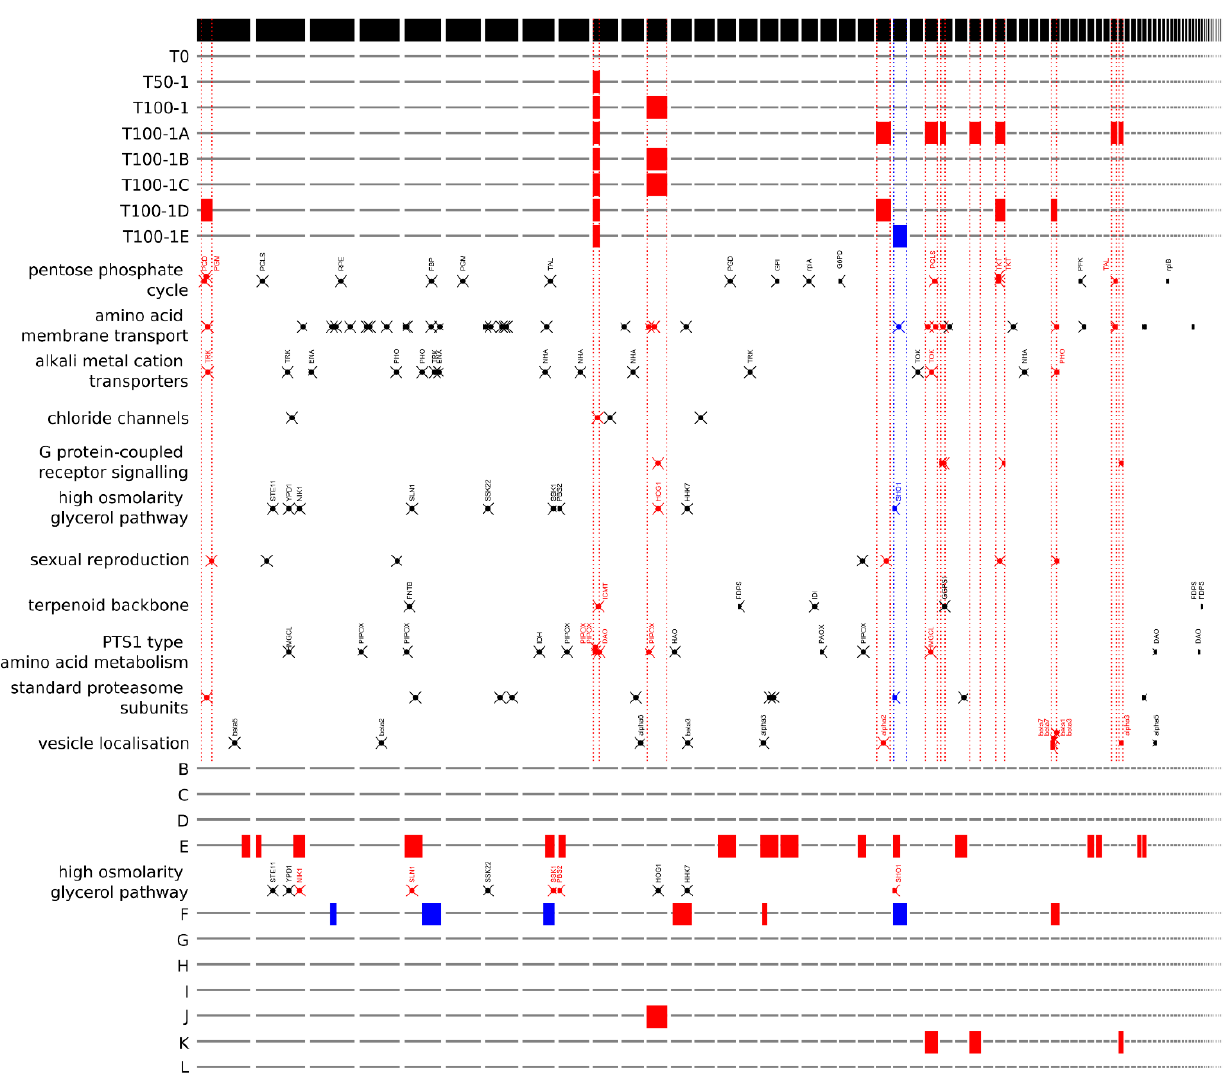
Figure 4. Position of aneuploid regions and selected gene groups in different strains of Hortaea werneckii . The location of the putative triploid (red) and haploid (blue) genomic regions is marked in relation to the contigs of the reference haploid genome, from left to right, from the longest to the shortest (black stripe on top). Evolved strains (T0 to T100-1E) and wild strains (B to L) of H. werneckii are shown in rows. Between them, the locations of selected genes are arranged in functional groups. Gene locations are marked with crosses. Genes were identified by PANTHER IDs (amino acid membrane transport, chloride channels, sexual reproduction, vesicle localisation), by KEGG orthology numbers (pentose phosphate cycle, G protein-coupled receptor signalling, terpenoid backbone synthesis, standard proteasome subunits, PTS1 type amino acid metabolism) or identified by manual searches for previously identified genes (alkali metal cation transporters, high osmolarity glycerol pathway).